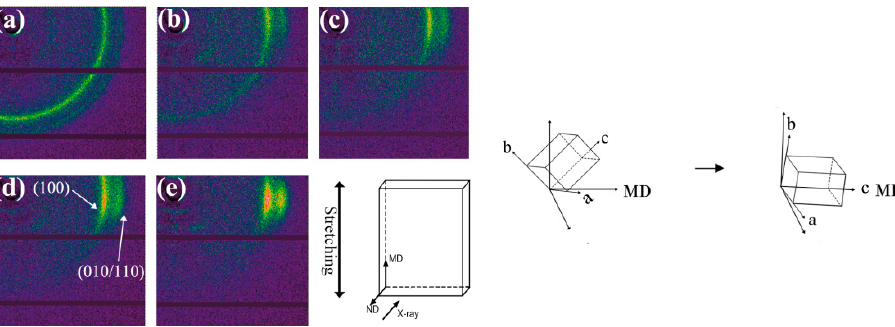
Figure 6. The 2D-WAXS of uniaxially stretched PA612/SiO 2 films at the strain of ( a ) ε = 0, ( b ) ε = 1, ( c ) ε = 1.5, ( d ) ε = 2, ( e ) ε = 2.5.